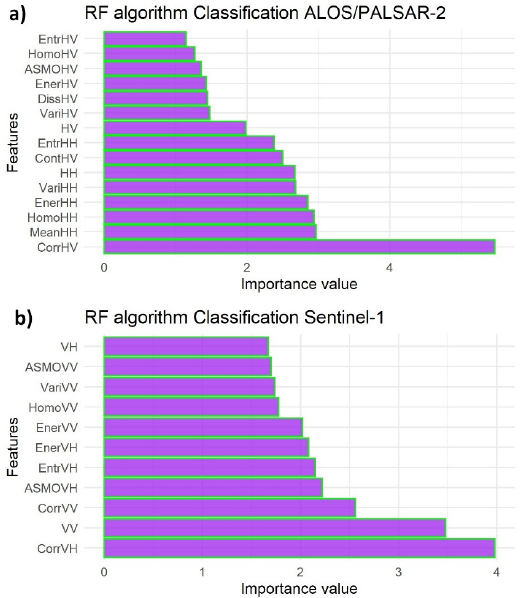
Figure 6. Ranking showing the most important features for the RF classification for the A5 ( a ) and S5 ( b ) experiments.